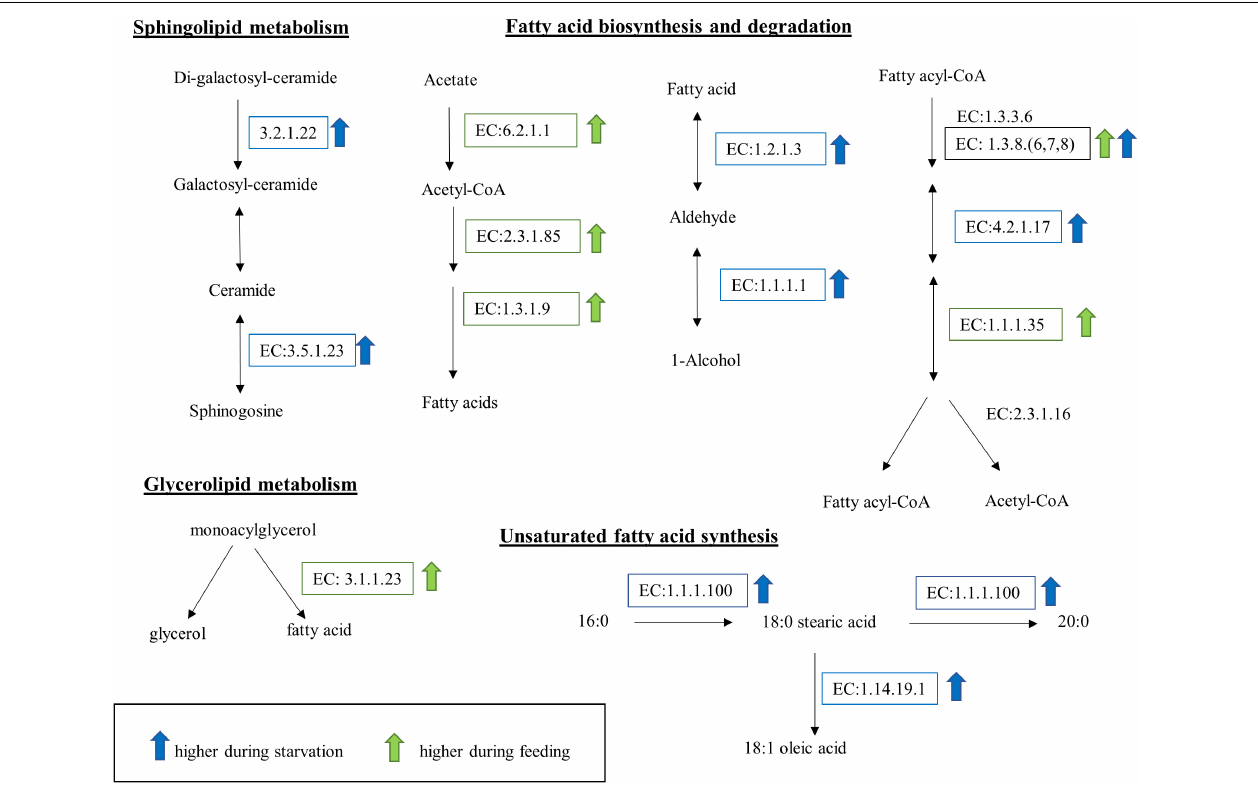
FIGURE 8 | Lipid and fatty acid metabolic pathways affected by feeding and starvation state in O. marina cells. Arrows and boxes indicate significantly differentially expressed transcripts in either the fed (green) or starved (blue) treatments. The upregulation of EC:1.3.8(6,7,8) in both treatments reflects the expression of different transcripts with the same EC